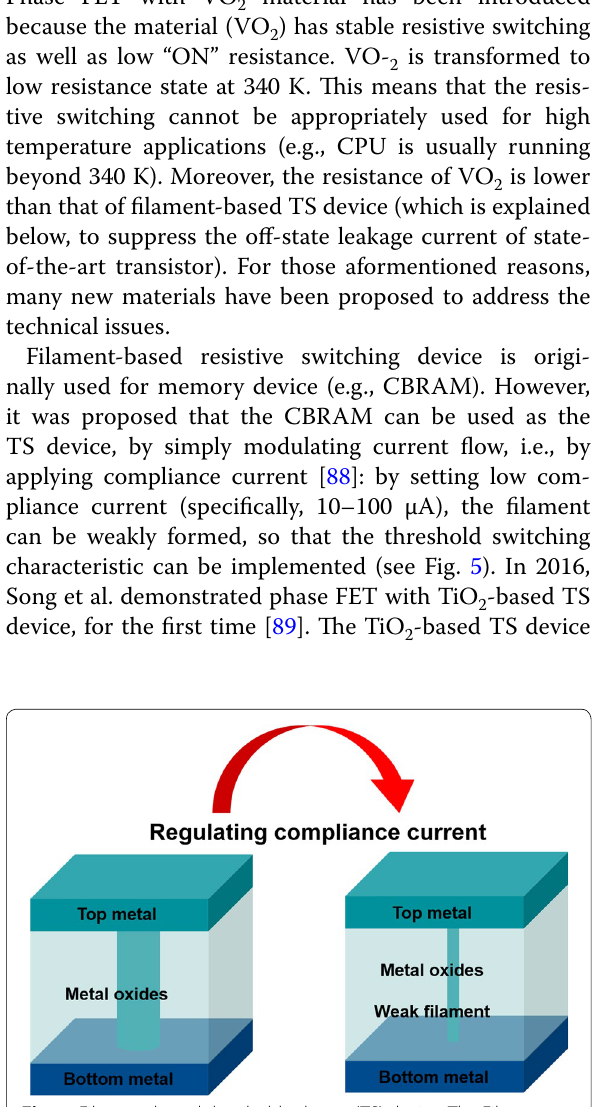
Fig. 5 Filament-based threshold selector (TS) device. The Filament of CBRAM can be unstable by modulating compliance current,